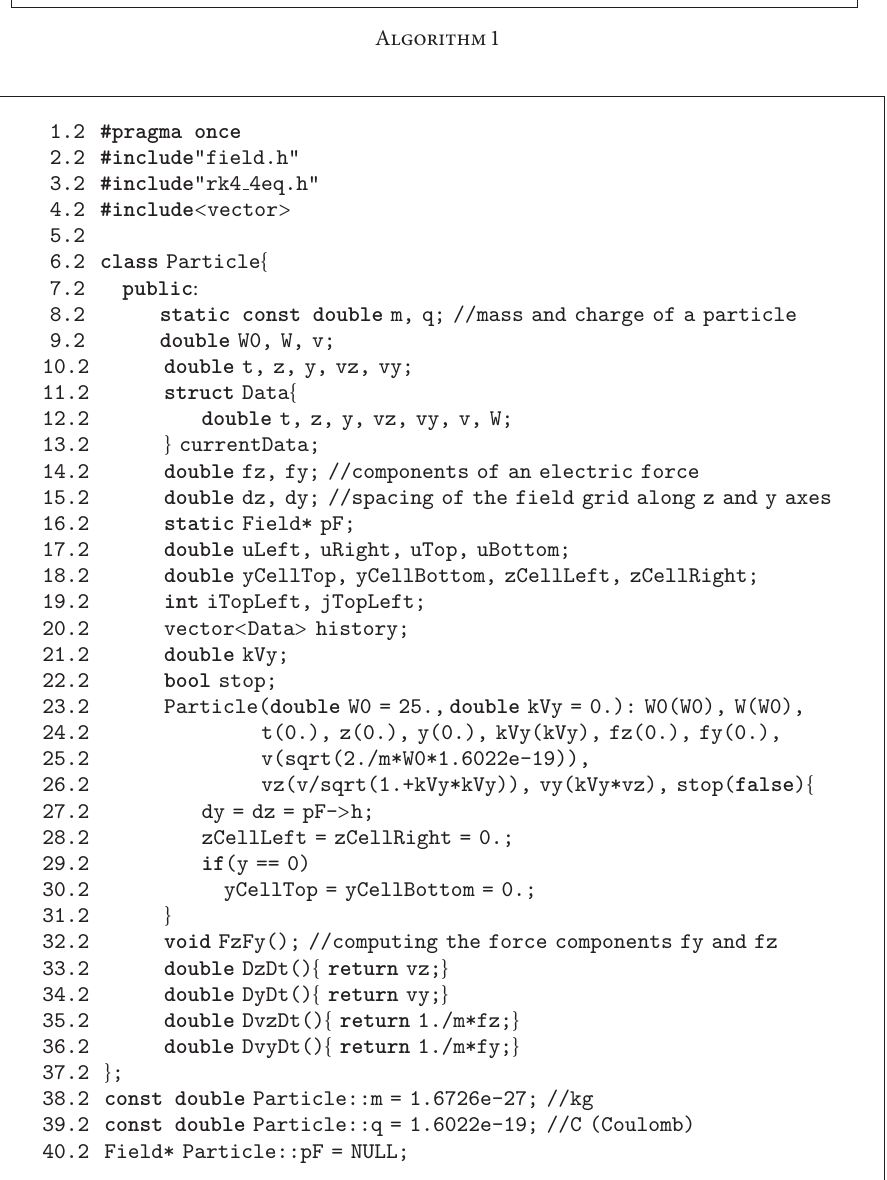
Algorithm 2: The header file particle.h defining the class Particle